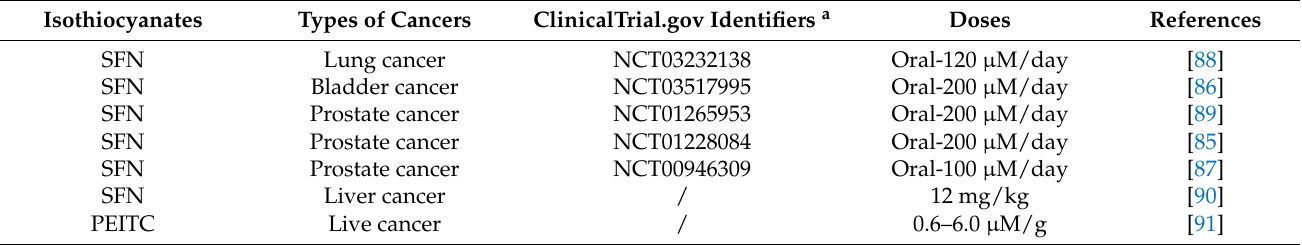
Table 2. Chemopreventive activity of isothiocyanates on hepatocellular carcinoma and other cancers in in vivo models.